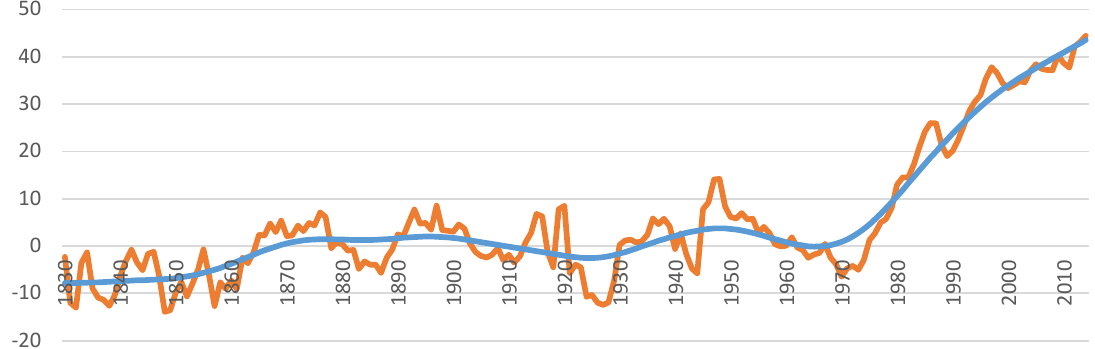
Figure 3. Norwegian GDP per capita relative to Western Europe for 1830–2015 in 2002,